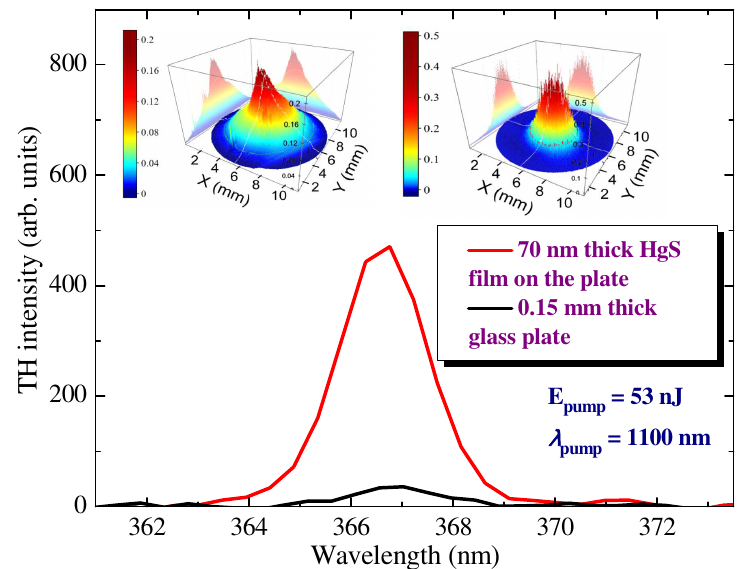
Figure 8. Characteristics of third-harmonic emission. Spectra of the third-harmonic emission from the pure silica glass substrate (d = 0.15 mm, black solid curve) and thin film (d = 70 nm) of HgS QDs deposited on the silica glass substrate (red solid curve). Inset: 3D spatial distributions of the third harmonic (right panel) and fundamental (left panel) beams.